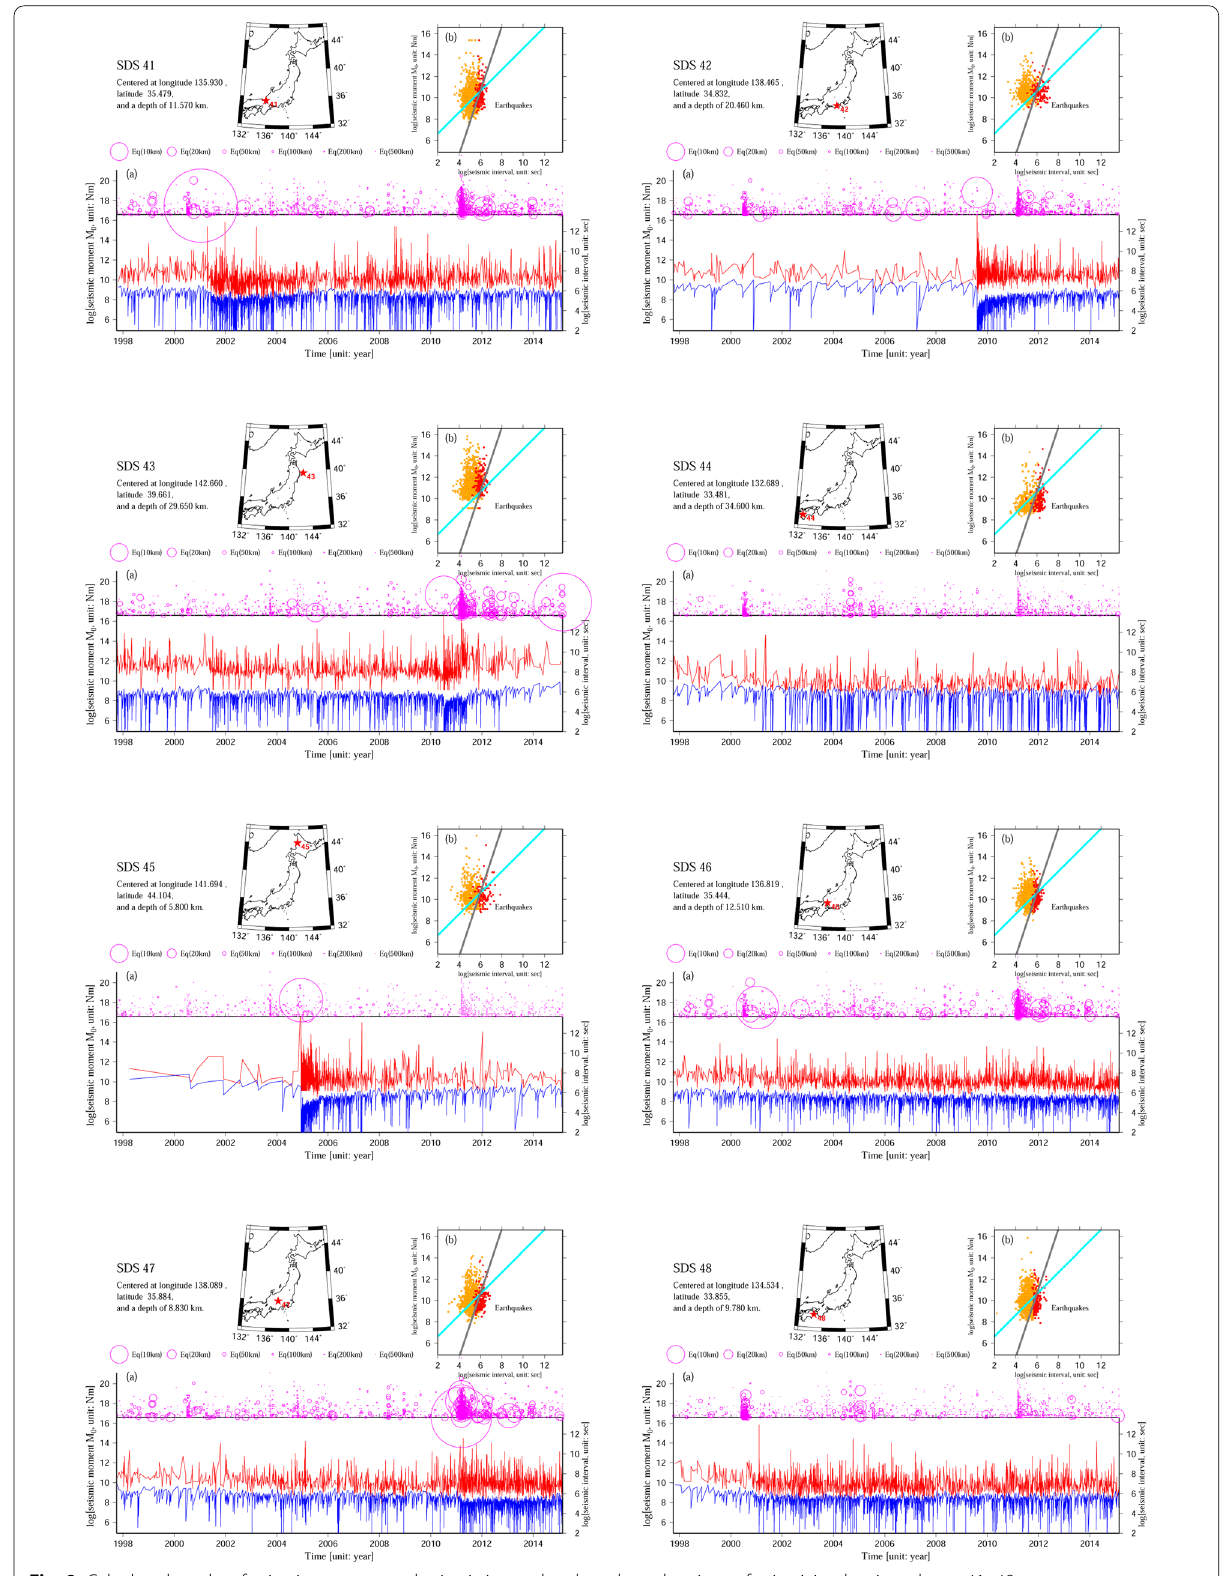
Fig. 8 Calculated results of seismic moment and seismic interval at the selected regions of seismicity density spheres